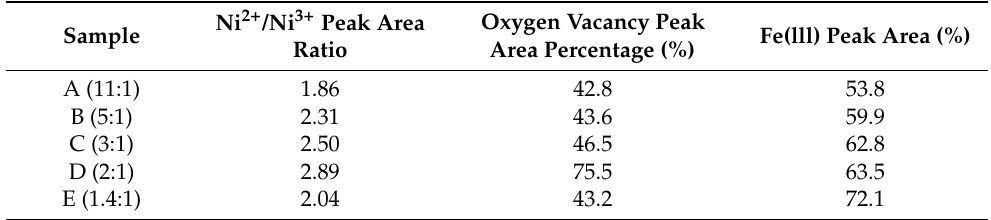
Table 3. Summary of peak area ratio of Ni(II)/Ni(III), oxygen vacancy peak area percentage and Fe(III) peak area percentage of the electrodeposited Ni–Zn–Fe on Ni foam in the different Ni:Fe ratio of the bath (A), (B), (C), (D), (E).